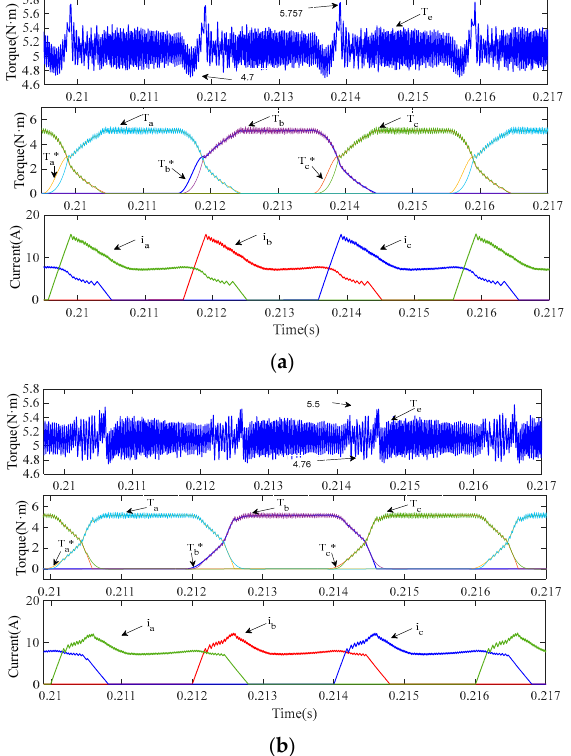
Figure 12. Simulation waveforms of torque and current: ( a ) conventional exponential TSF at 500 r/min; ( b ) proposed NUTSF at 500 r/min.